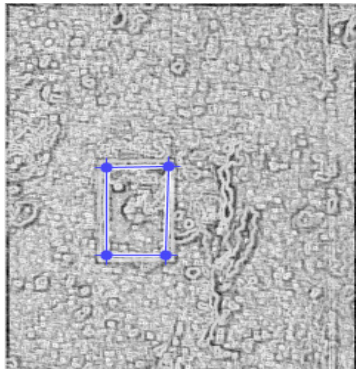
Figure 10. Applying the mask for lacunarity calculation.